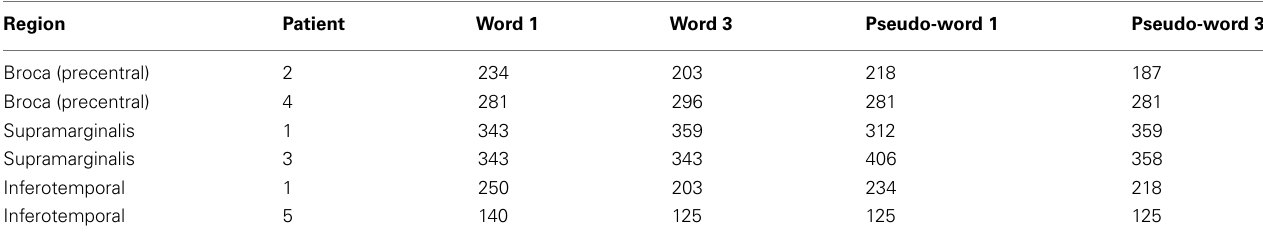
For each condition, all latencies were estimated as the first time sample that elicited significant difference of the amplitude between post-stimulus gamma-band response and the average baseline amplitude [Wilcoxon paired-test comparison, corrected for multiple comparisons